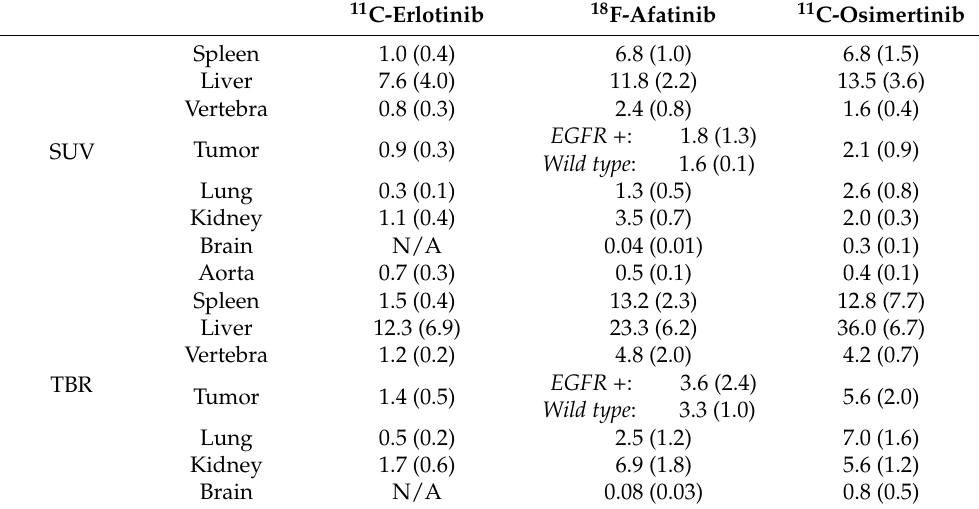
Table 3. Static SUV and TBR values given per